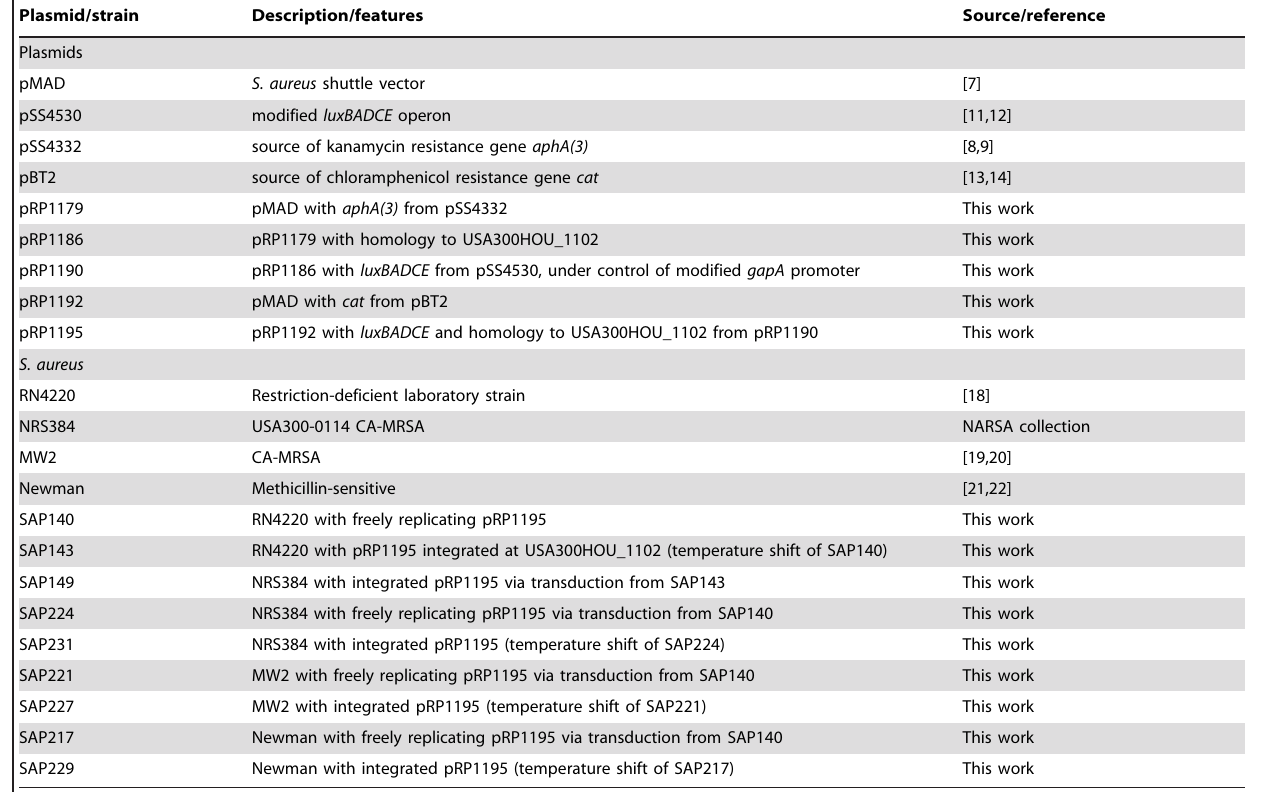
Table 1. Plasmids and strains used in this work.